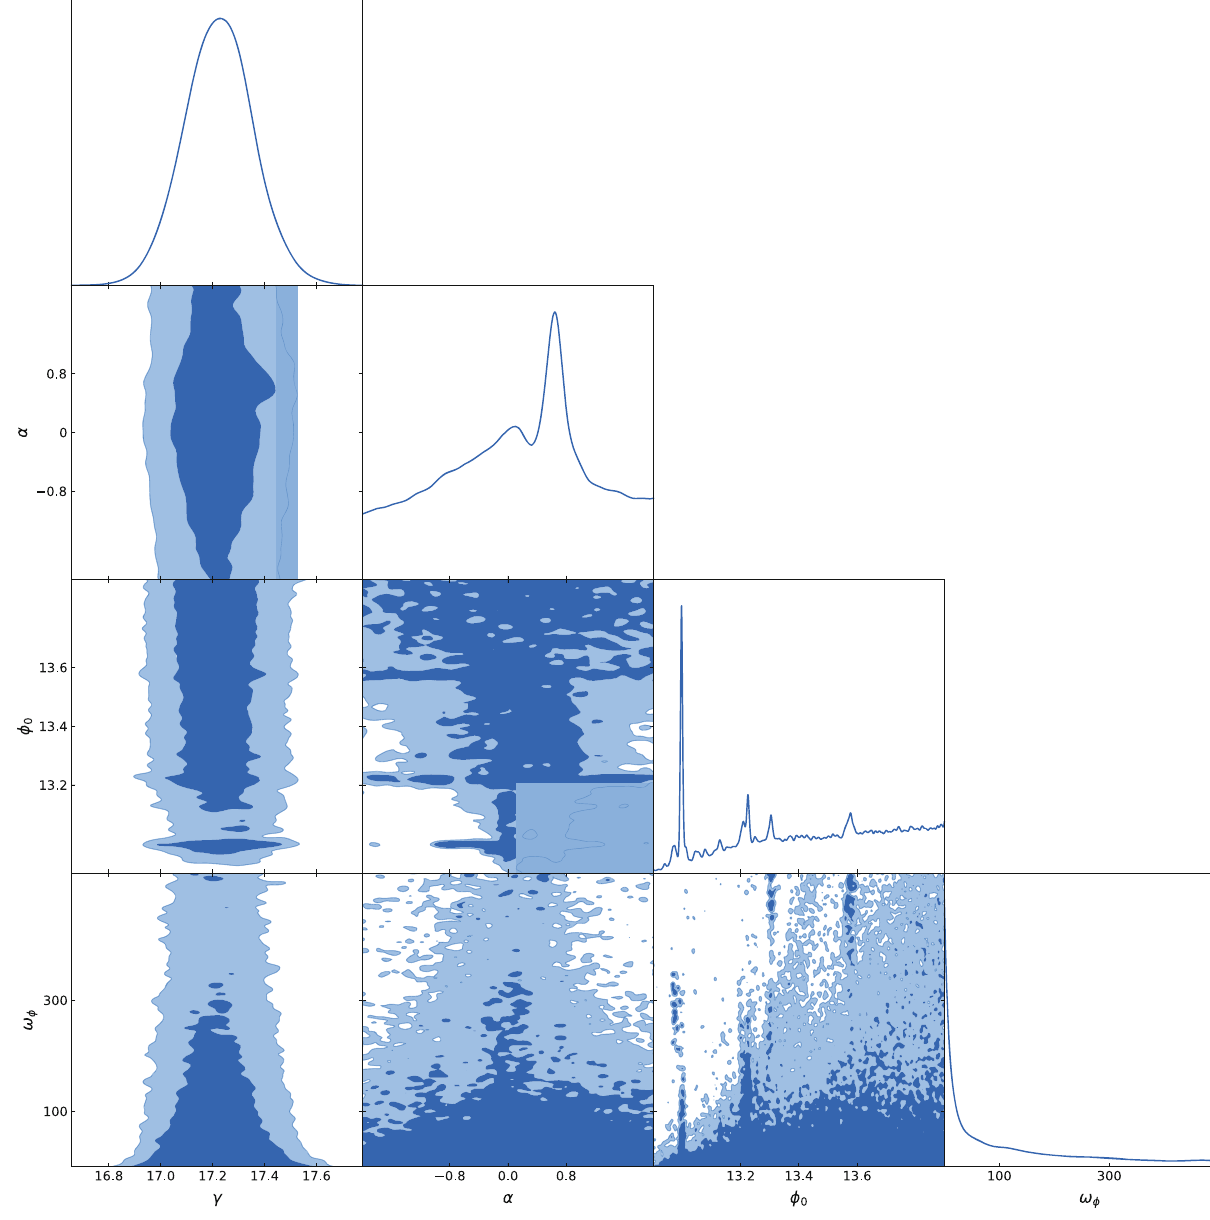
Fig. 3 The figure contains the triangle plot for the feature model parameters corresponding to Plik bin1. Here we can see multiple region in parameter space which could lead improved fit to data using different combination of these parameters